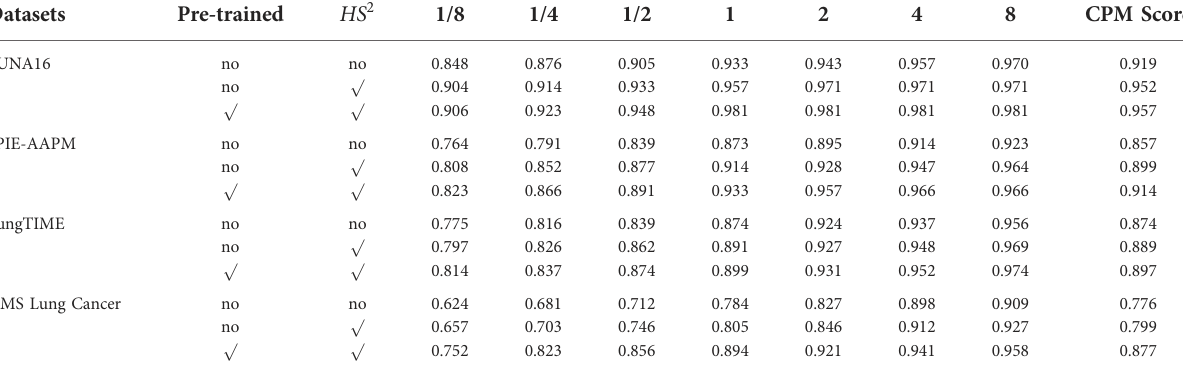
TABLE 5 FROC Performance comparison with and without using the pre-trained model, with and without false positive reduction: sensitivity and the corresponding false positives at 1 = 8 , 1 = 4 , 1 = 2 , 1 , 2 , 4 , 8 per scan. The 3DFPN-HS 2 is only fi ne-tuned (with the pre-trained model)/trained (without the pre-trained model) on LUNA16 training set and tested on LUNA16 test set. At all levels of false positives per scan, the sensitivities of the framework using a pre-trained model and false positive reduction signi fi cantly outperform the one without the pre-trained model and false positive reduction. Datasets